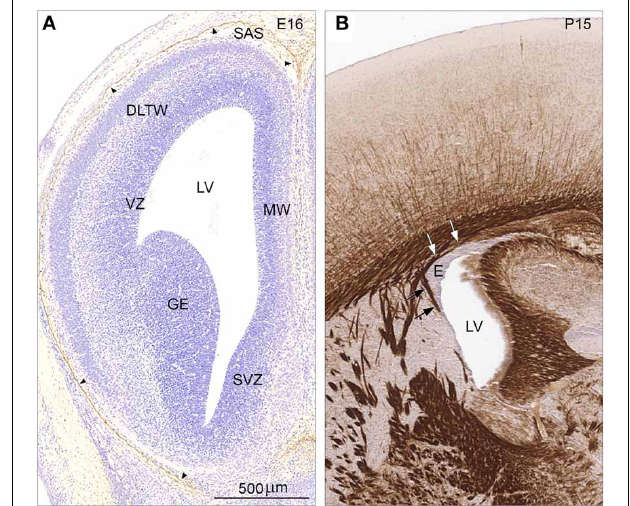
FIGURE 8 | Distribution of claudin-11/OSP immunoreactivity in coronal sections of E16 (A) and P15 (B) mouse forebrain. (A) Immunostaining for claudin-11/OSP of the early developing forebrain at E16 demonstrates a lack of reactivity in the entire telencephalic wall. Thus, the apical surface of ventricular zone (VZ) facing the lateral ventricle (LV) is devoid of immunostaining in all subregions— DLTW, dorsolateral telencephalic wall; MW, medial wall; SVZ, septal ventricular zone and GE, ganglionic eminence. The developing arachnoid barrier layer ( arrowheads ) is however, claudin-11/OSP positive. Leptomeningeal cells in the subarachnoidal space (SAS) and on the outer surface of the telencephalic wall are not stained. (B) . At P15 the ependymal zone (E) of lateral ventricle (LV) is unstained in marked contrast to the strongly stained tight junctions of myelin sheaths in early subependymal oligodendrocytes ( arrows ). Same magnification in (A,B) , scale bar 200 μ